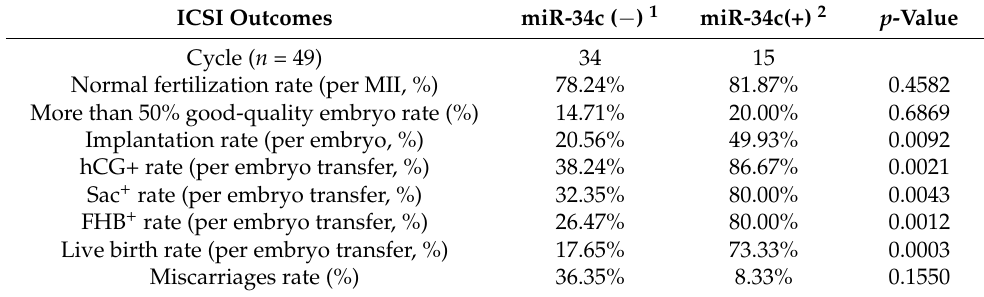
Table 3. Comparison of sperm miR-34c levels and ICSI outcomes in men with teratozoospermia. ICSI Outcomes miR-34c ( − ) 1 miR-34c(+) 2 p -Value Cycle ( n = 49) 34 15 Normal fertilization rate (per MII, %) 78.24% 81.87% 0.4582 More than 50% good-quality embryo rate (%) 14.71% 20.00% 0.6869 Implantation rate (per embryo, %) 20.56% 49.93% 0.0092 hCG+ rate (per embryo transfer, %) 38.24% 86.67% 0.0021 Sac + rate (per embryo transfer, %) 32.35% 80.00% 0.0043 FHB + rate (per embryo transfer, %) 26.47% 80.00% 0.0012 Live birth rate (per embryo transfer, %) 17.65% 73.33% 0.0003 Miscarriages rate (%) 36.35% 8.33%